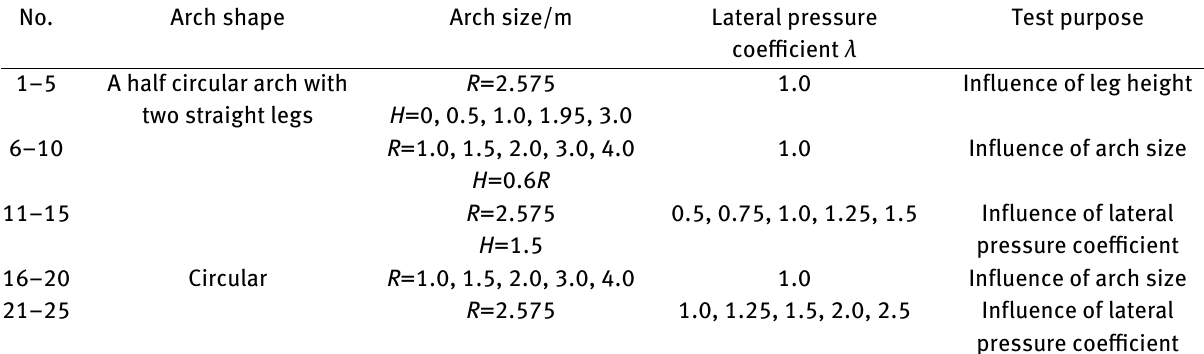
Table 1: Numerical simulation test scheme